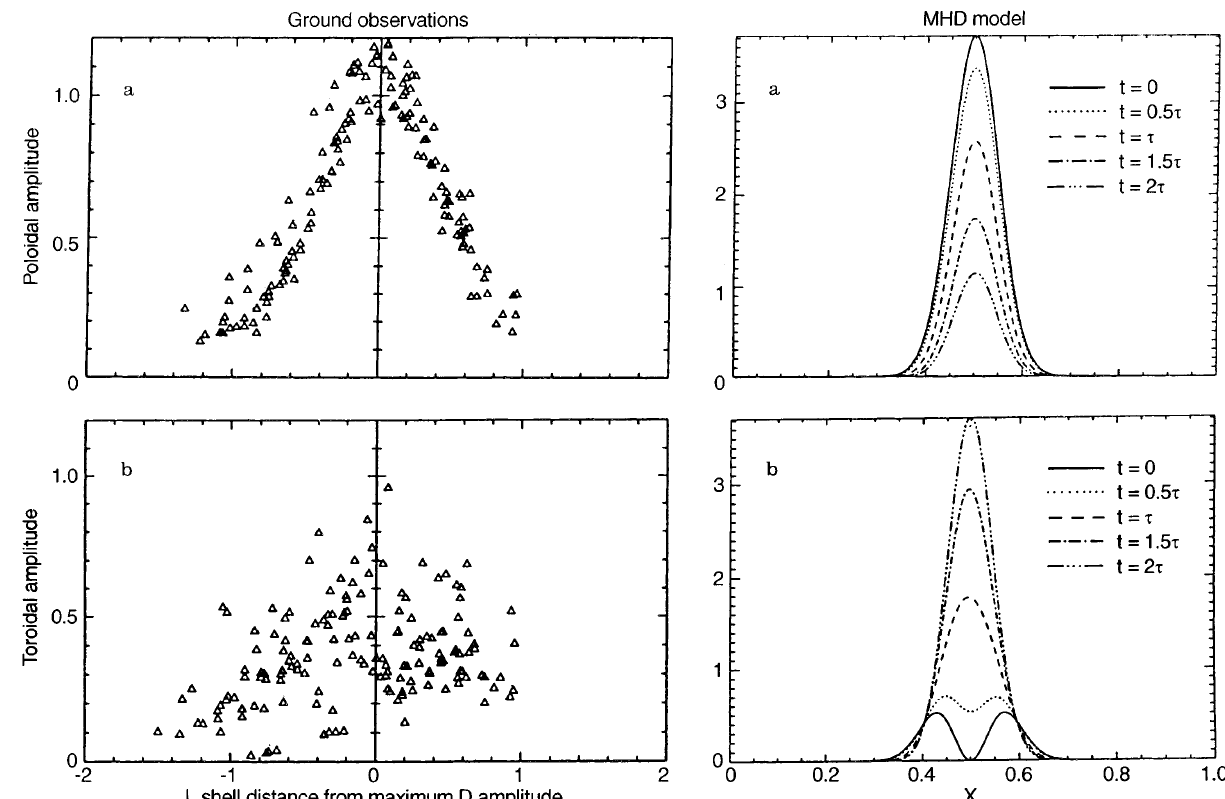
Fig. 14. Comparison of observation ( left ) and MHD model ( right ) of the latitudinal amplitude profile of giant pulsations (adapted from Fig. 7 and 8 of Chisham et al